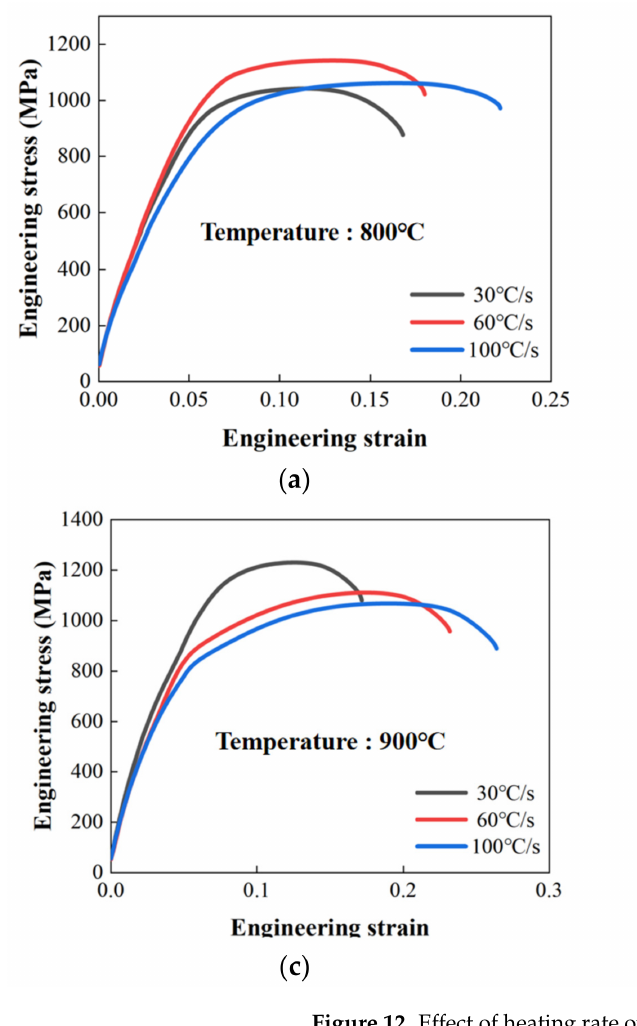
Figure 12. Effect of heating rate on the engineering stress-strain curves at the heating temperatures of